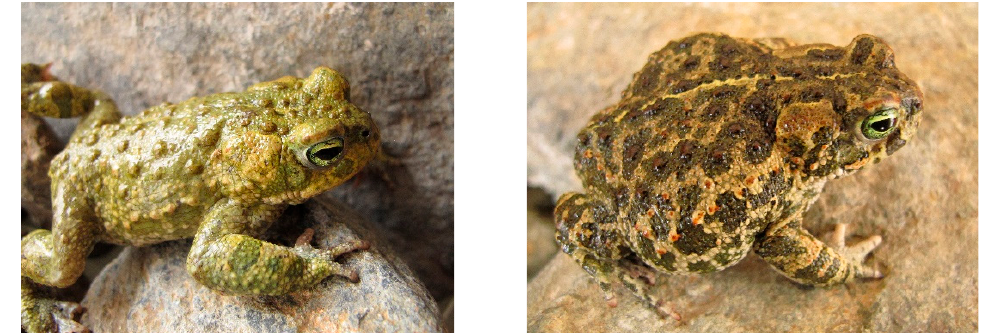
Figure 1. The images show the great variability in colour of the back of the natterjack toad that can also have a clear and light, narrow mid-dorsal line (photos by J.R. Vallejo).